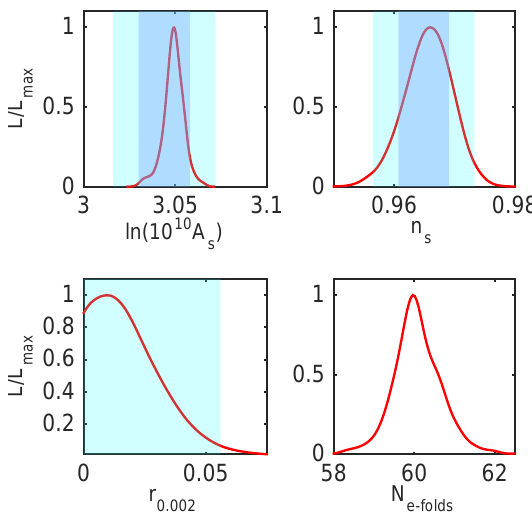
Figure 3. Marginalised likelihood probability distributions of the main inflationary parameters from the fit of the dark Higgs inflation model with curvature corrections with the P LANCK TT, TE, EE + lowE + lensing + BK15 dataset. The distributions are obtained at k ∗ = 0.002 Mpc − 1 and include the uncertainty in the number of e-folds. For comparison we also show the corresponding 65% (dark blue) and 95% (light blue) limits from the fit of Λ CDM model with the same dataset [2].